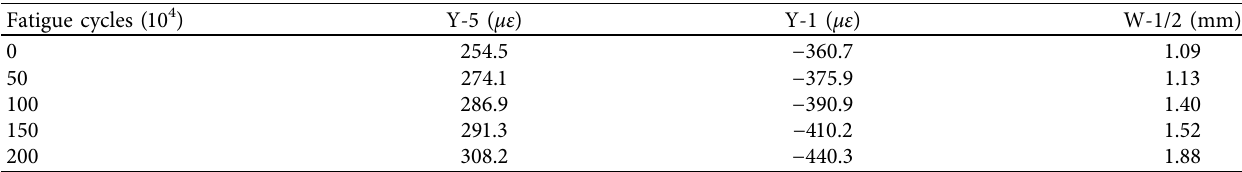
Table 14: The relation between deflections and strain and fatigue loading times for steel-plate-reinforced plate (corroded by carbonization) under the 200kN